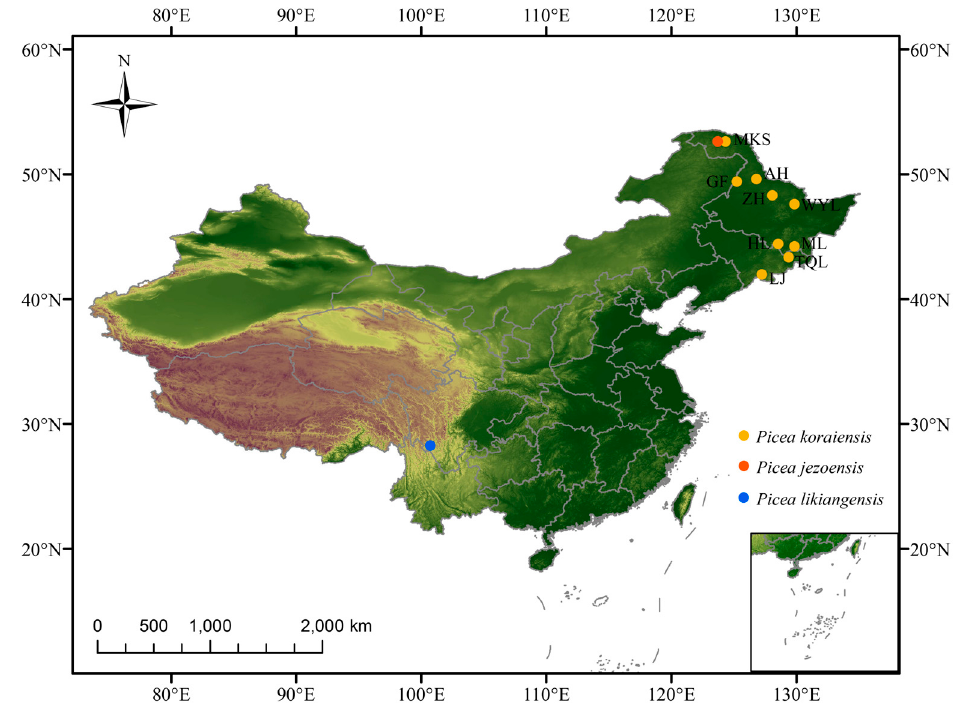
Figure 7. Geographical distributions of 9 populations of P. koraiensis with altitude as the base map. Table 2. Locations of 9 P. koraiensis populations.